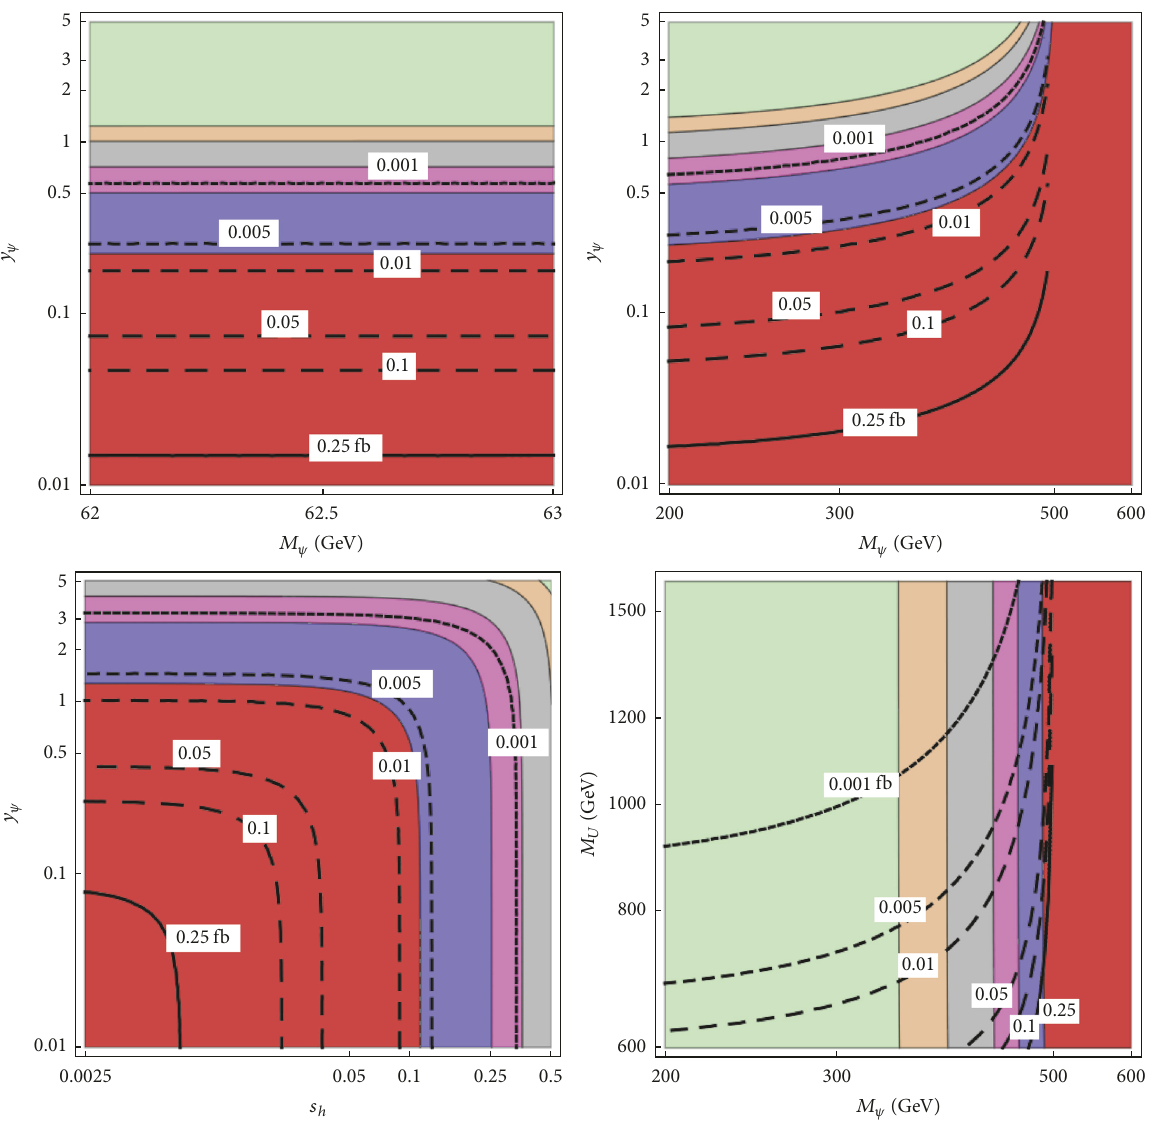
= 0.01 , 𝑀 = 475 GeV, ℎ 휓